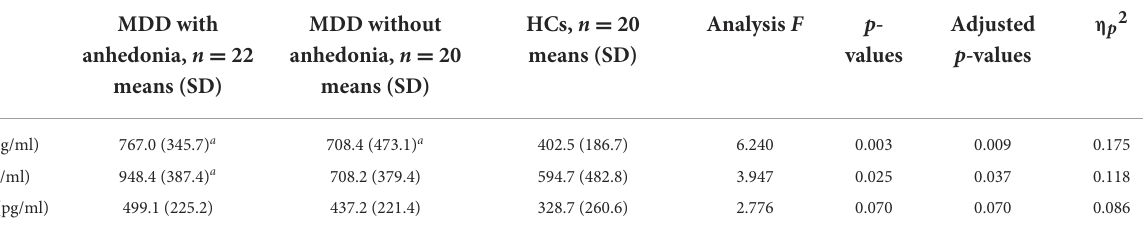
TABLE 2 Comparisons of plasma levels of inflammatory factors among three groups ( n =